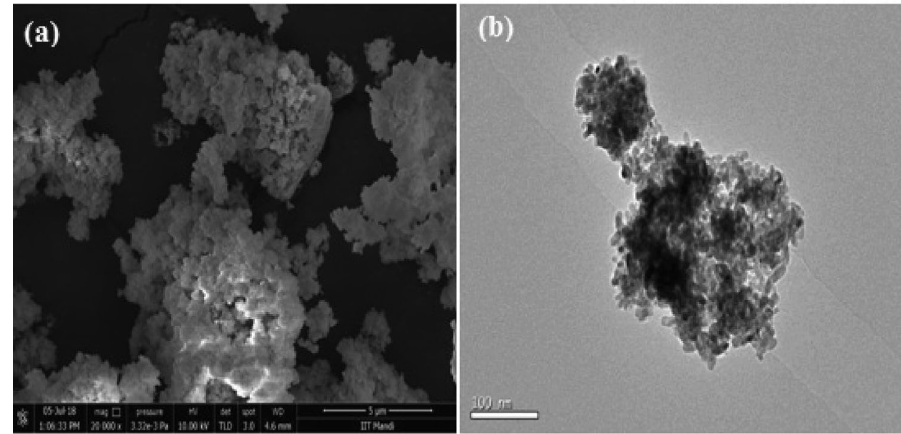
Figure 9. (a) SEM and (b) TEM images of YbPO 4 :Tb 3+ ferent synthetic procedures are shown in Figs. 4–9. SEM images of YbPO 4 :Tb 3+ (SC) dispose the square shaped